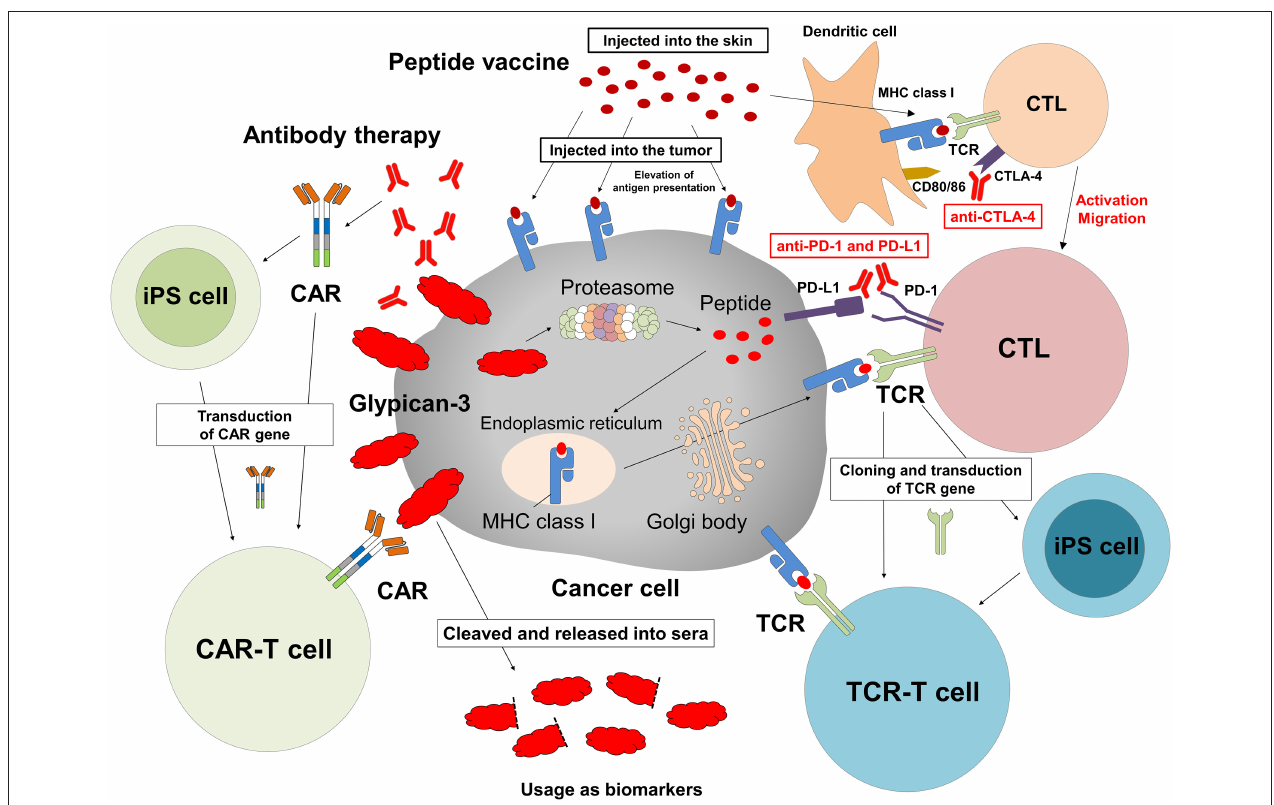
FIGURE 2 | Cancer immunotherapy targeting GPC3. Therapeutic approaches that target intracellular GPC3 include GPC3 peptide vaccine and adoptive immunotherapy based on T cells transduced with a suitable TCR. In contrast, antibody therapy and anti-GPC3-CAR-transduced T cell therapy target membrane-bound GPC3. We are currently developing such T cells and CAR-T cells from iPS cells. In addition, intratumoral vaccination and combination with immune checkpoint inhibitors might enhance effects of these treatments, and serum GPC3 could be a